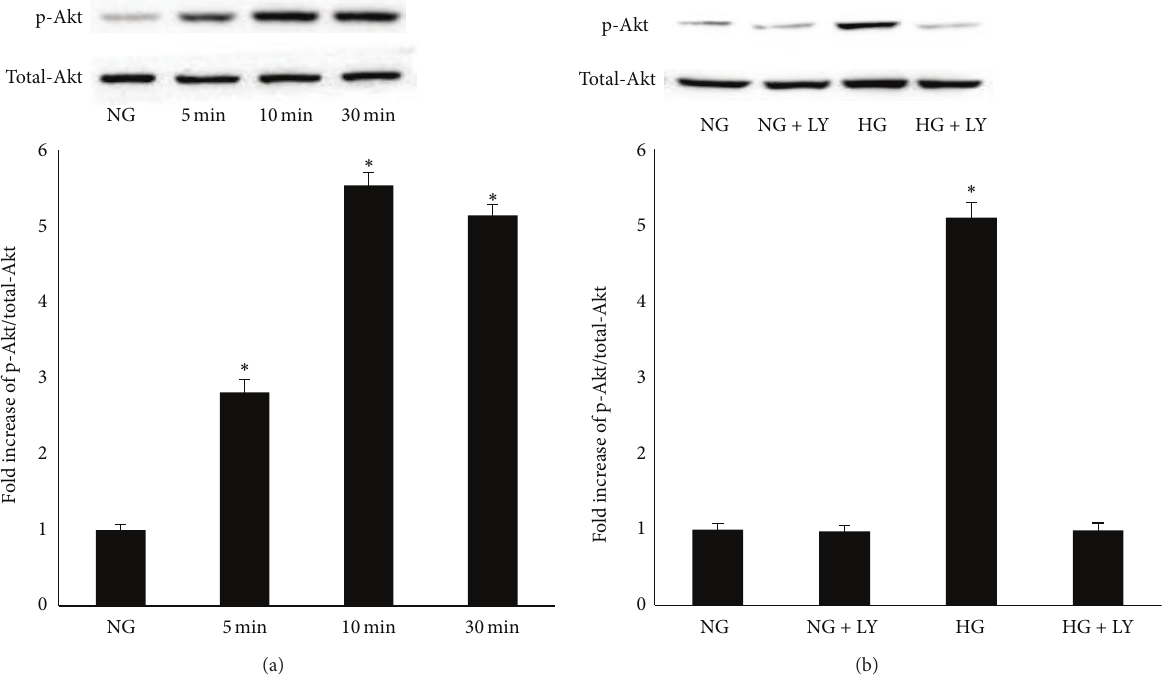
Figure 4: (a) Activation of Akt by high glucose in RPE cells. PRE cells were stimulated with high glucose (25mM) for the indicated periods of time, and cell lysates were immunoblotted with anti-p-Akt and anti-Akt antibodies. ∗ 𝑃 < 0.001 versus NG. (b) RPE cells were pretreatment with 20 𝜇 M LY294002 for 30 min and then incubated with high glucose for 30 min for assay of Akt phosphorylation. Levels of phosphorylated Akt were determined with western blot analysis. The data represent the mean ± standard deviation (SD) of three independent experiments. ∗ 𝑃 < 0.001 versus NG or HG +